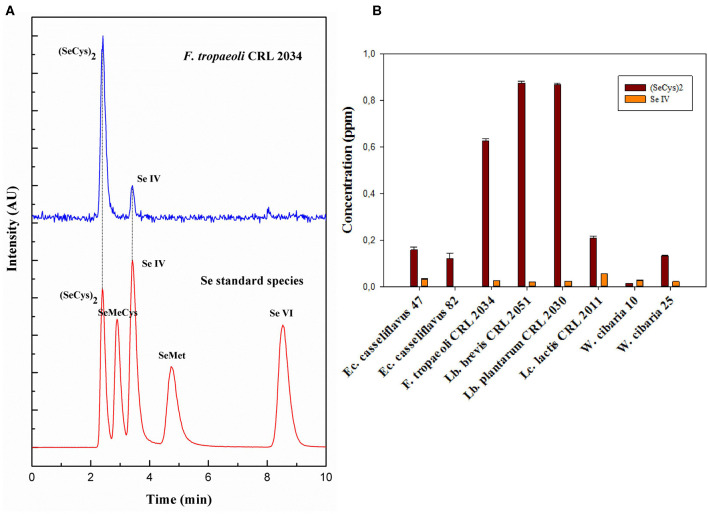
Se species in enzymatically hydrolyzed LAB cell pellets. (A) Anion exchange ICP-MS chromatograms of standard Se species, and Se species formed by F. tropaeoli CRL 2034 (as example) are represented in red and blue, respectively. (B) Se species concentration for the assayed LAB. AU, arbitrary units.